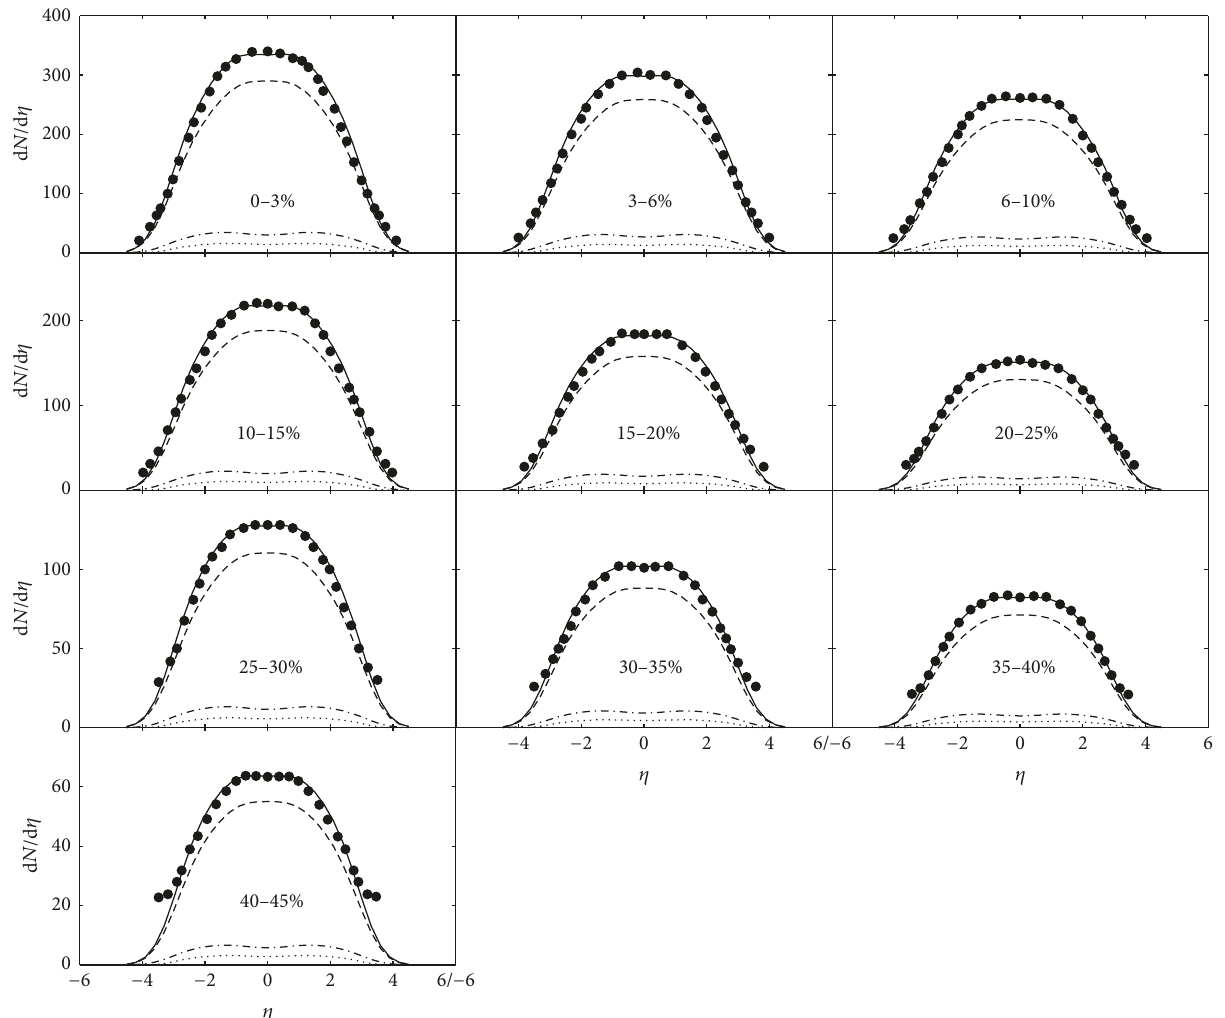
Figure 3: The pseudorapidity distributions of charged particles produced in different centrality Au+Au collisions at √𝑠 NN = 19.6 GeV. The solid dots are the experimental measurements [5]. The dashed, dashed-dotted, and dotted curves are, respectively, the contribution from pions, kaons, and protons got from the hydrodynamic results of (18). The solid curves are the sums of the three types of